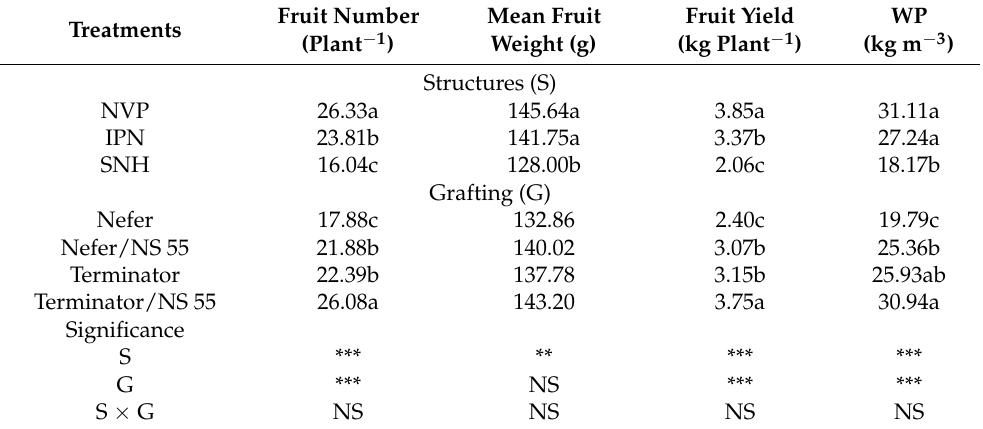
Table 3. Effect of structures and graft combinations on yield parameters and water productivity (WP).